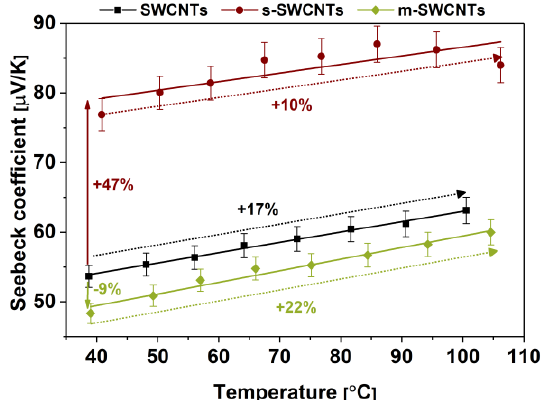
Figure 8. Seebeck coe ffi cients of thin films from unsorted, metallic, and semiconducting SWCNTs. Horizontal arrows compare the increase or decrease of initial Seebeck coe ffi cients of metallic and semiconducting films as related to the parent material. The arrows, which span across selected temperature ranges, on the other hand, compare the Seebeck coe ffi cients of the respective SWCNT networks as related to the initial value of electrical Seebeck coe ffi cients recorded at the starting temperature.